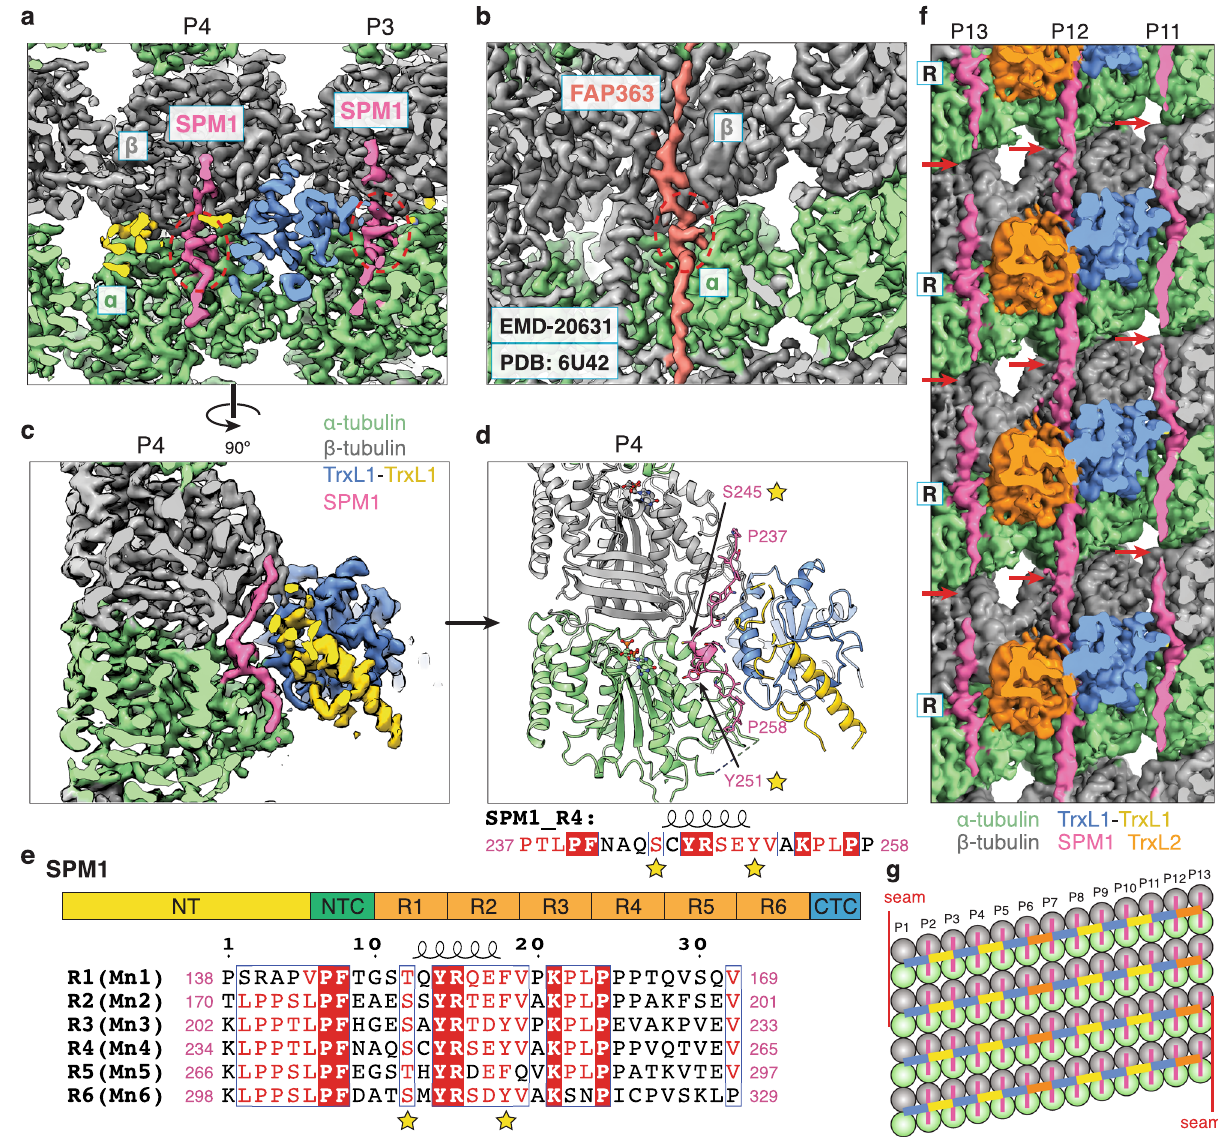
Fig. 3 The interactions between SPM1, TrxL1/2, and tubulin. a Cutaway view of the cryo-EM density showing a short α -helix (red dashed circle) of SPM1 (pink) bound at the intra-dimer interface between α - and β -tubulin (green and gray, respectively). b Cutaway view of the cryo-EM density of FAP363, a Mn-motif containing protein, bound to the Chlamydomonas ciliary doublet MT 25 . c 90-degree rotation of panel a, showing SPM1 is sandwiched between tubulin and TrxL1. d Same view as panel c, but only displaying the atomic models. The two conserved residues (characteristic of the Mn motif) of SPM1 are marked by yellow stars (same in panel e). We arbitrarily assigned the protein sequence of the SPM1 density to be R4 for the purpose of model building. e Above: schematic of the domain organization of SPM1. NT: N-terminal domain, NTC: N-terminal conserved domain, CTC: C-terminal conserved domain. Below: sequence alignment of the six internal repeats (R1-R6) of SPM1. f Luminal view of the MIP densities at proto fi laments 11 – 13 (P11 – 13). Unsharpened cryo-EM density map is used to better visualize the connectivity of SPM1. The red arrows point to a region of SPM1 with weaker densities (except for the SPM1 on P12), presumably due to incoherent averaging of divergent residues between R1-R6. g Schematic of the MT lumen that is cut open and unfurled at the